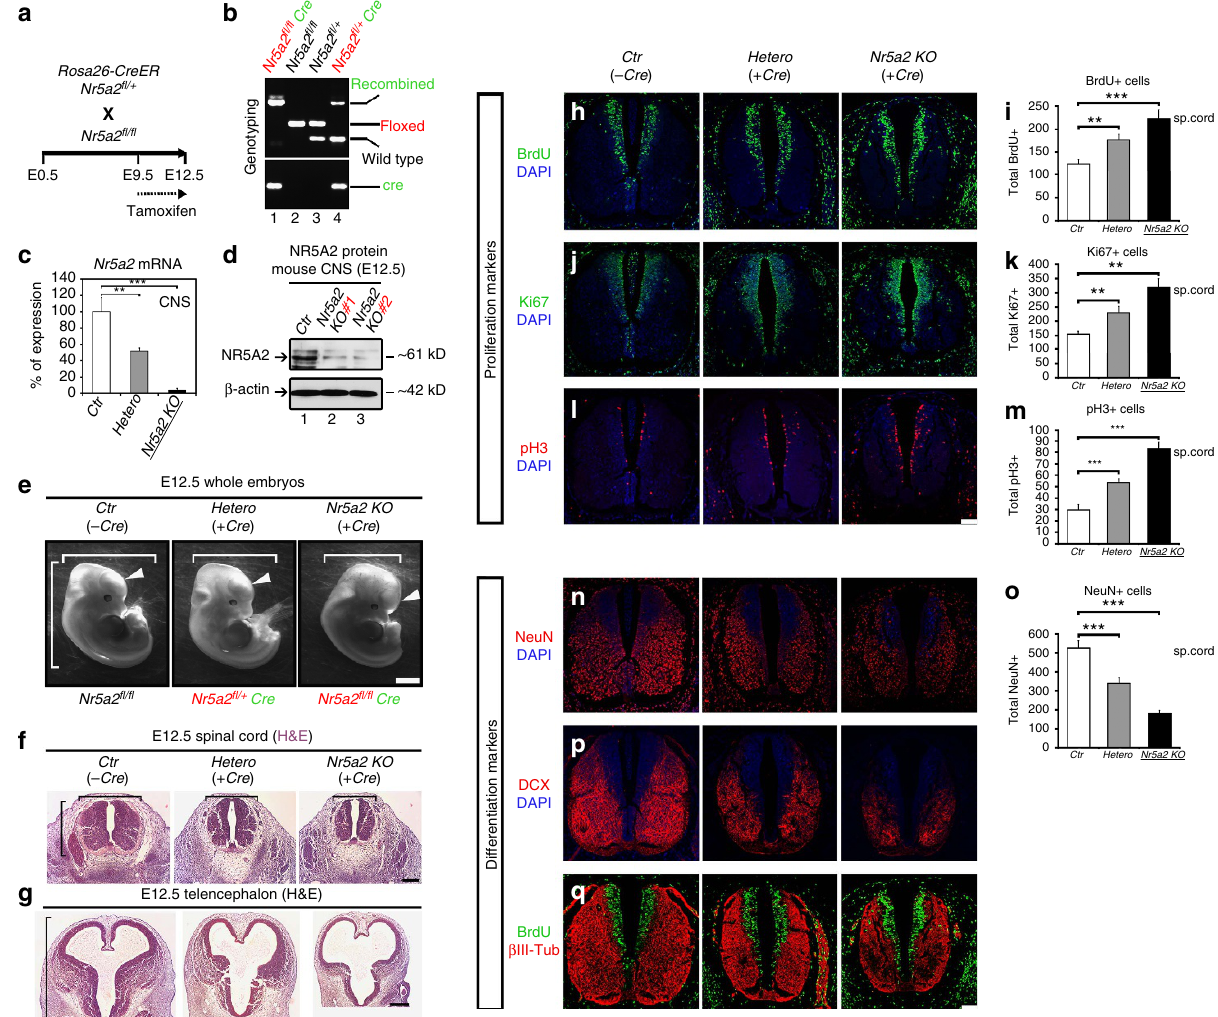
Figure 4 | Temporal deletion of NR5A2 affects mouse CNS development. ( a ) Schematic representation of the knockout strategy. ( b ) Assessment of recombination of the floxed Nr5a2 locus by genotyping PCR in CNS tissue, as indicated. Note the efficient recombination of the floxed Nr5a2 alleles in the presence of a single allele of CreER (lane 1). ( c , d ) RT–qPCR ( c ) and western blot ( d ) analyses in E12.5 CNS of Ctr , Hetero and Nr5a2 KO animals for the detection of Nr5a2 mRNA and protein levels, respectively. ( e ) Stereoscopic views of E12.5 Ctr , Hetero and Nr5a2 KO whole-mouse embryos. The white arrowheads depict the forebrain of each embryo. Note the large difference in the size of the forebrain of Nr5a2 KO mice (right panel). ( f – g ) Histological sections of E12.5 spinal cords ( f ) and E12.5 telencephalons ( g ) of Ctr , Hetero and Nr5a2 KO littermates, stained with haematoxylin & eosin. Note the substantial size reduction of both structures (square brackets) in Nr5a2 KO embryos and to a lesser extent in Hetero embryos. ( h – q ) Phenotypic analysis of Hetero (centre panels) and Nr5a2 KO (right panels) spinal cords, compared with Ctr (left panels), in relation to various proliferation ( h – m ) or differentiation ( n – q ) markers, as indicated. Note the ectopic proliferating cells (BrdU þ , Ki67 þ , pH3 þ ) that are localized outside the VZ and do not express neuronal markers (for example, b III-Tubulin). Quantifications of BrdU þ , Ki67 þ , pH3 þ and NeuN þ cells are shown in i , k , m and o , respectively (total marker þ /spinal cord section). All values represent the mean ± s.d. of four animals ( n ¼ 4). ** P o 0.01, *** P o 0.001 (Student’s t -test). Scale